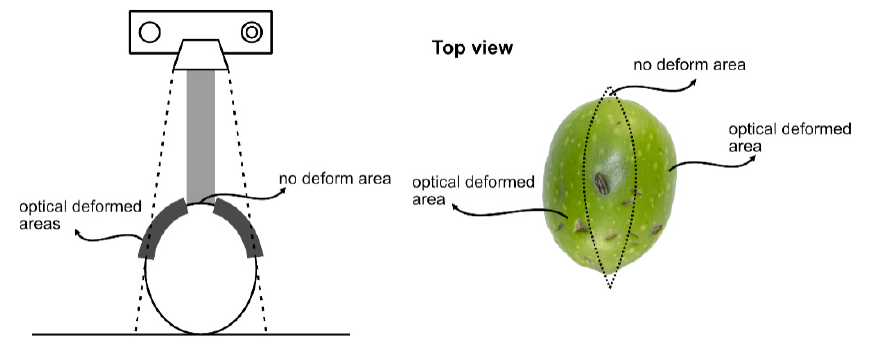
Figure 13. Optical deformation scheme affecting bruise spot measurements.